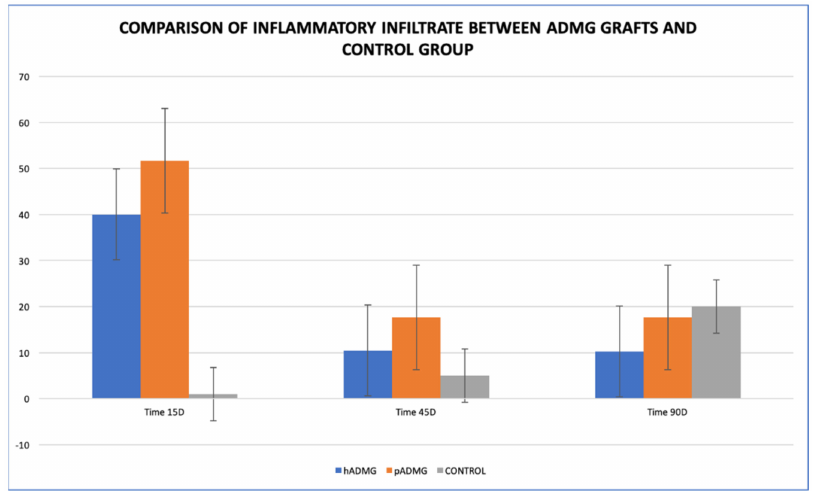
Figure 6. Comparison of inflammatory infiltrates between dADMG, mADMG grafts and Control